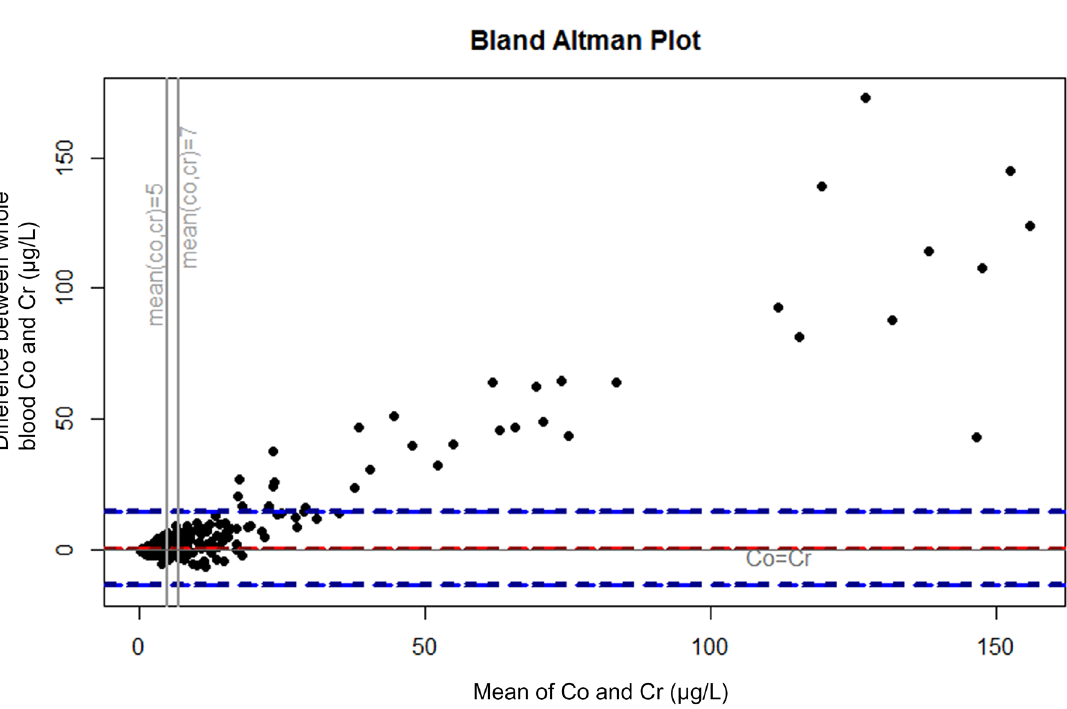
Figure 4. Bland–Altman plot representing the difference between whole blood Co and Cr in relation to the mean of whole blood Co and Cr (µg/L) in patients with unilateral or bilateral hip resurfacings. In the measurements below zero the whole blood Cr is higher than Co. The red line represents mean difference and blue lines 95% confidence intervals. Measurements before/without revision surgery. Figure drawn with RStudio R (Version 3.5.1) 21